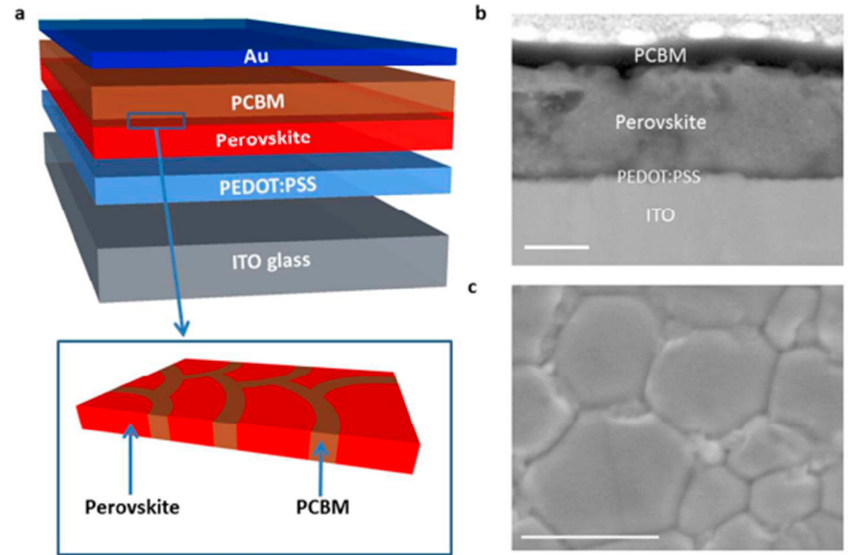
Figure 5. Perovskite solar cell structure: ( a ) schematic representation of the perovskite solar cell’s architecture; the zoomed-in diagram shows the hybrid material created. ( b ) Perovskite solar cells were grown with PCMB assistance and TEM cross-section view. Scale bar: 100 nm. ( c ) The view from above SEM image of a perovskite film that was grown using a CB-assisted process in conditions similar to those for PCMB-assisted growth. Scale bar: 1 μ m [90].